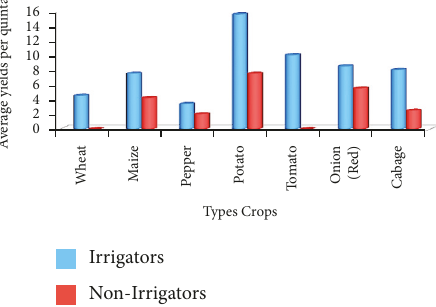
Figure 3: Average crop yields per quintal and per household (1 quintal (cid:31)